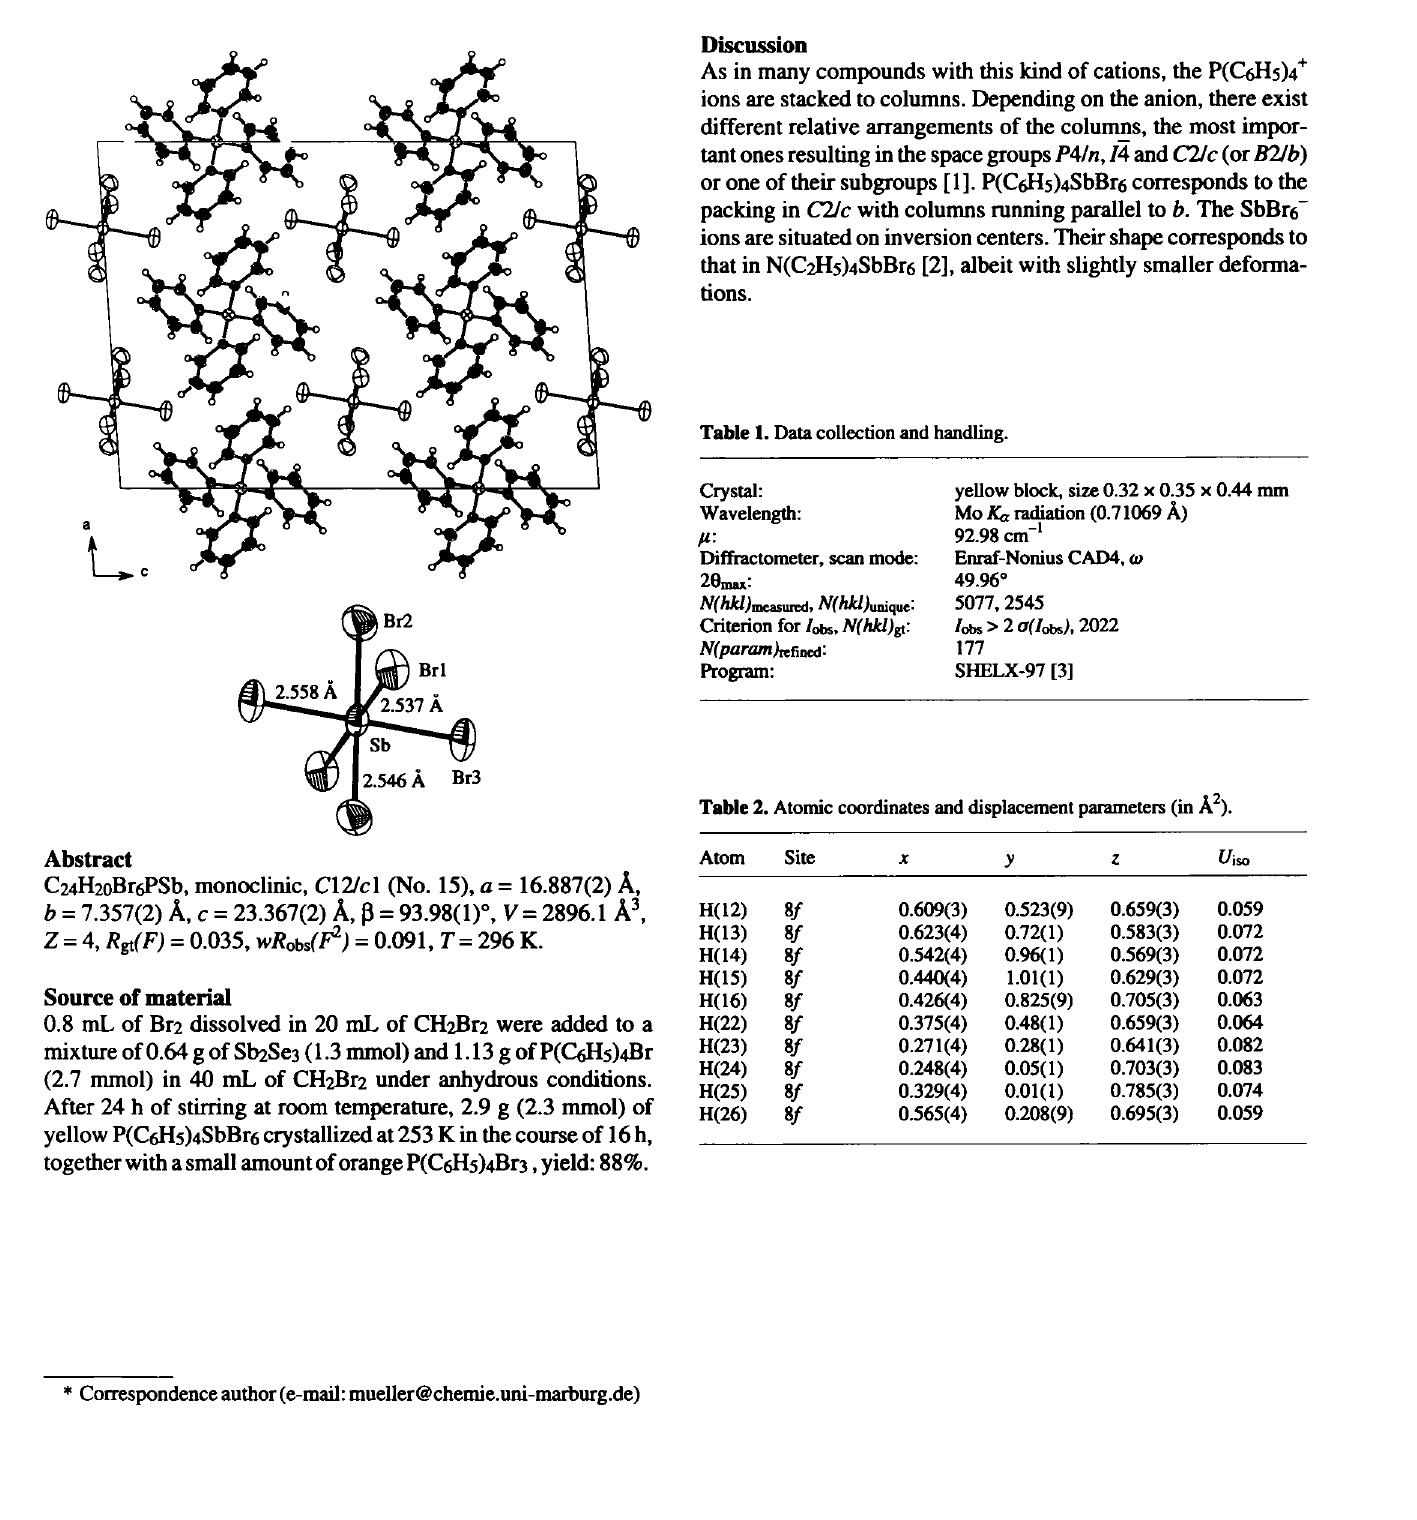
Table 1. Data collection and handling.